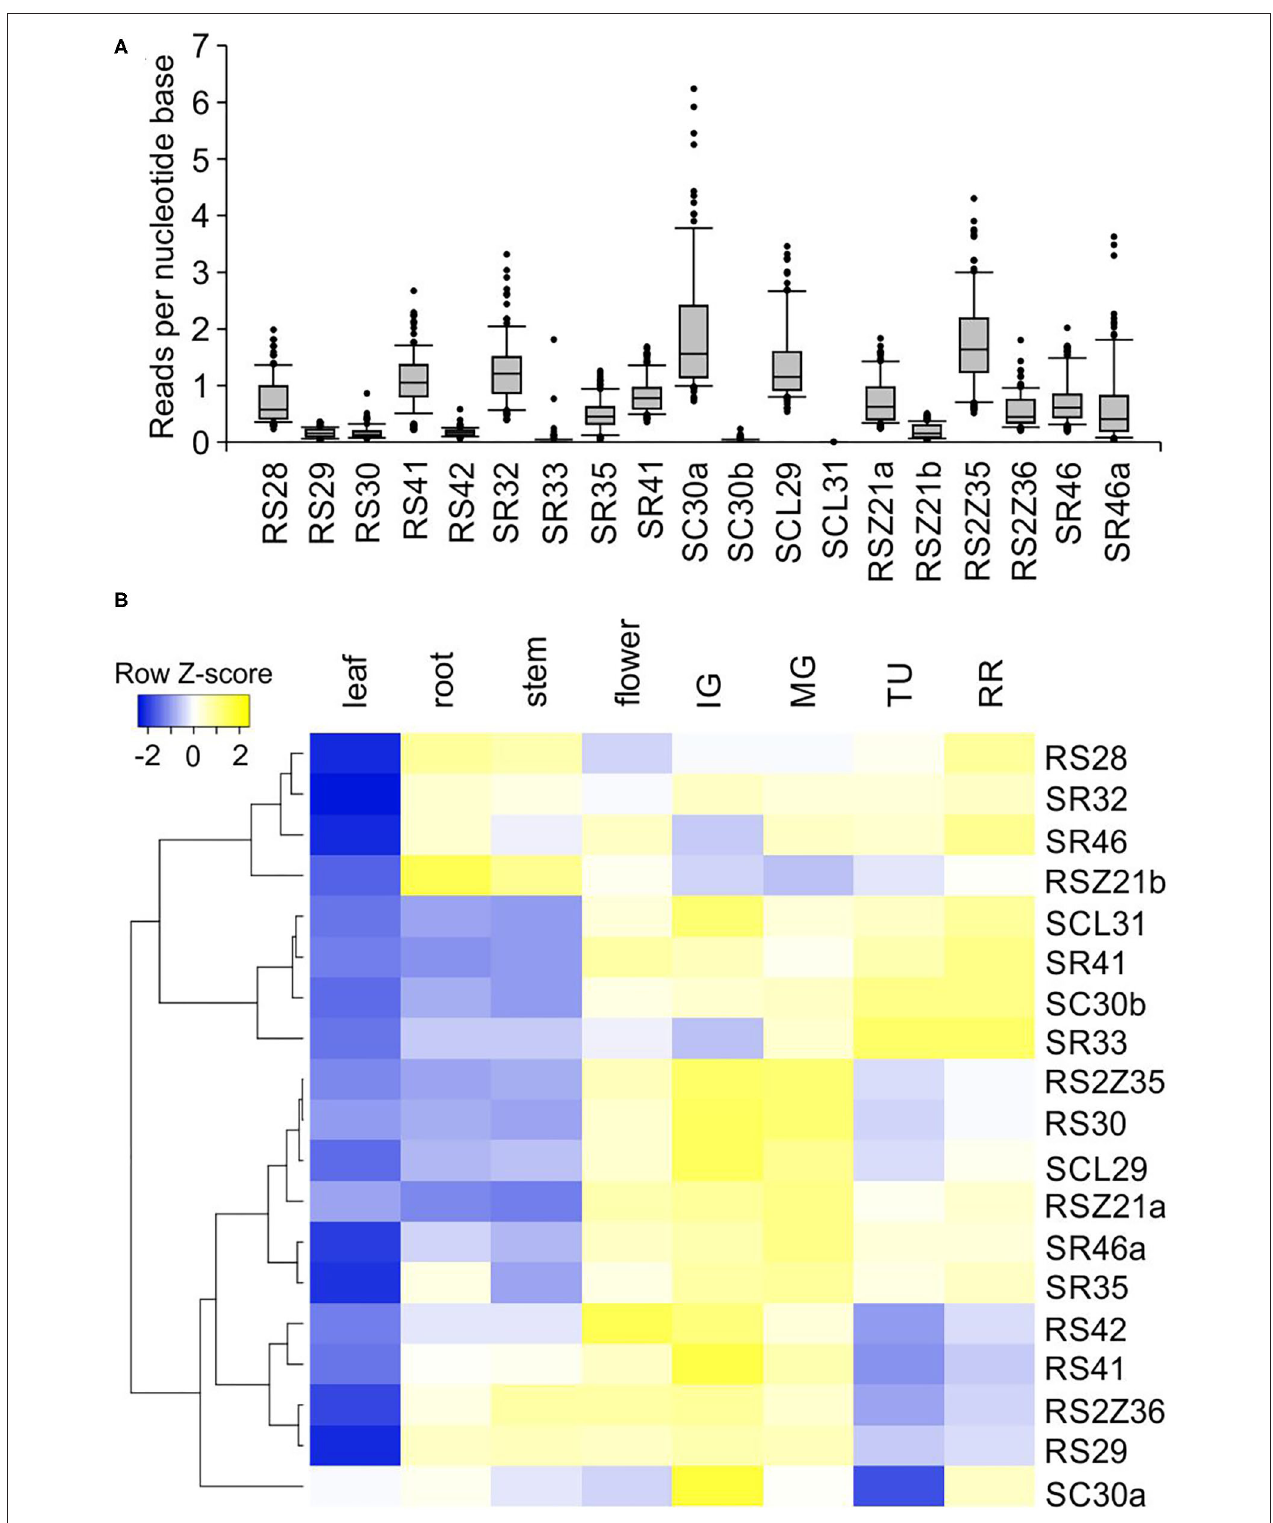
FIGURE 3 | Expression of SR protein genes in different tomato organs and tissues. (A) Global expression profiles of each SR across 106 samples. Quantile boxplots (0.25, 0.75) show the distribution of the log2 transformed reads per nucleotide base normalized values obtained from TOMEXPRESS database ( n = 106;